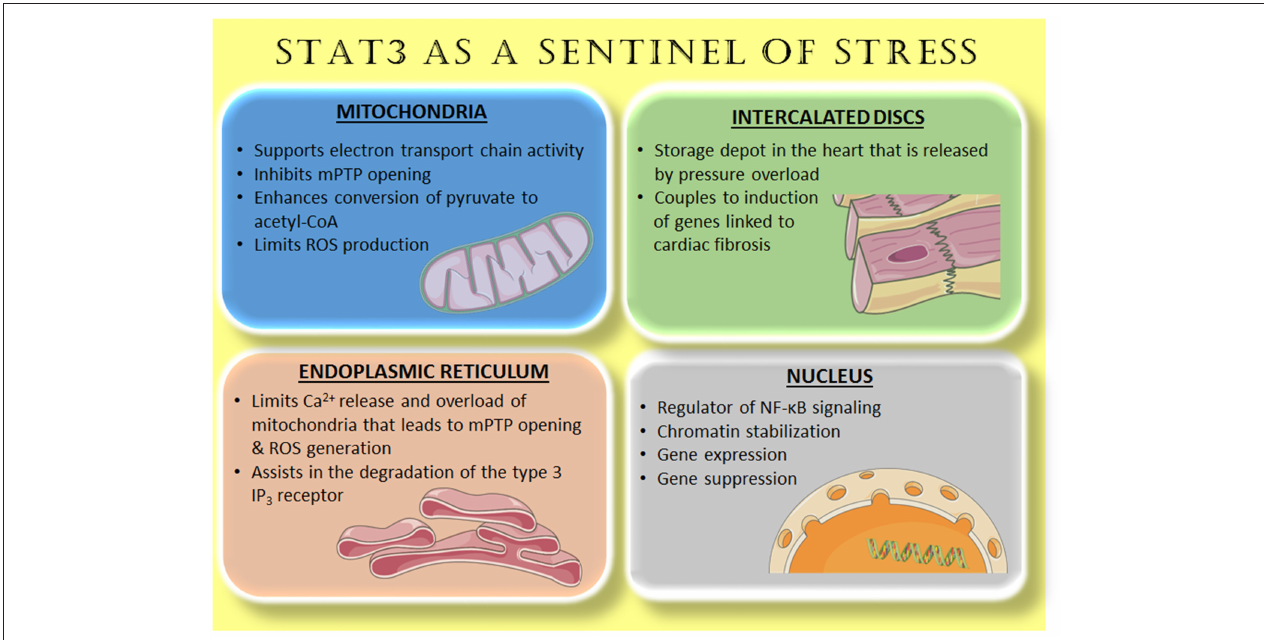
FIGURE 1 | STAT3 as a sentinel of stress. Accumulating evidence reveals that STAT3 is located within various cellular compartments, or relocates there with stress stimuli. In this capacity, STAT3 serves to maximize efficient respiration, limit ROS generation, and prevent apoptosis with ischemia-reperfusion (mitochondria and endoplasmic reticulum). In the nucleus, constitutive, and enhanced STAT3 modulates cytokine and inflammatory signaling. A pool of STAT3 constitutively associated with β IV -spectrin at intercalated discs responds to increased wall stress on the heart by remodeling of the extracellular matrix through gene induction. See text and previous reviews ( 1, 3) for additional details. Images are from Servier Medical Art (https://smart.servier.com/).